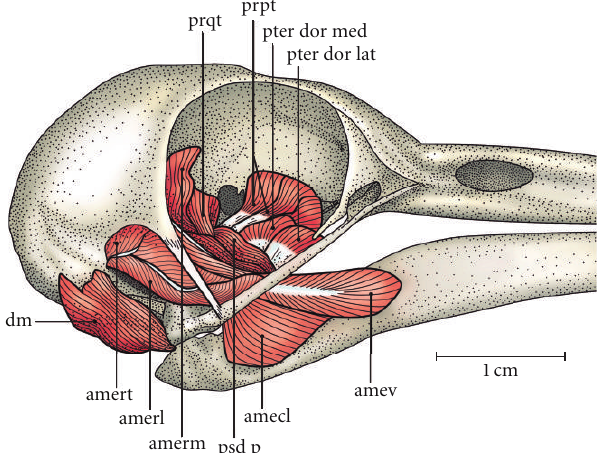
Figure 3: A lateral superficial view of the jaw muscles of Picus mentalis. amecl: adductor mandibulae externus caudalis lateralis; amerl: adductor mandibulae externus rostralis lateralis; amerm: adductor mandibulae externus rostralis medialis; amert: adductor mandibulae externus rostralis temporalis; amev: adductor mandibulae externus ventralis; dm: depressor mandibulae; prpt: protractor pterygoidei; prqt: protractor quadrati; psd p: pseudotemporalis profundus; pter dor lat: pterygoideus dorsalis lateralis; pter dor med: pterygoideus dorsalis medialis.